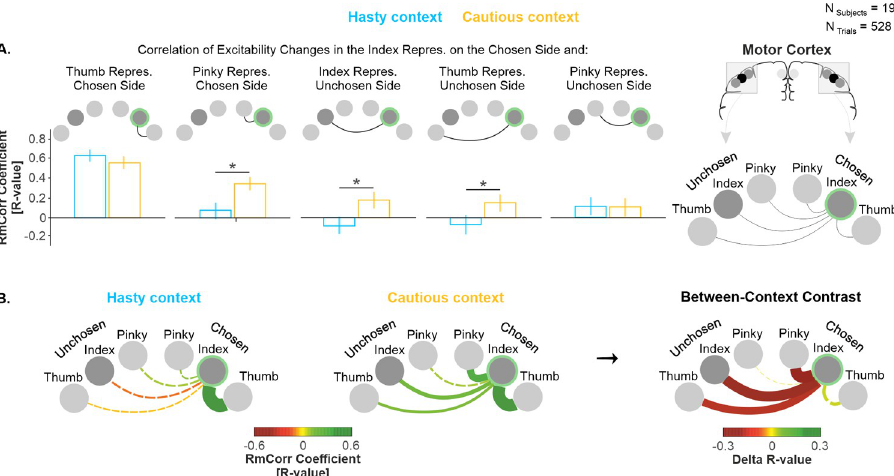
Error bars represent 95% CI. � indicates a significant difference between R-values at p < 0.01 (Bonferroni-corrected threshold), detected using Fisher Z test. (B) Network plots. The color and thickness of the lines in the left and middle panels represent the strength of the correlations, as indexed by RmCorr’s R-values. Solid and dashed lines represent significant and nonsignificant correlations, respectively. In the right panel, the color and thickness of the lines represent the difference in R-values between the cautious and the hasty context. Solid and dashed lines represent significant and nonsignificant different in correlation, respectively, as determined using Fisher Z test. All individual and group-averaged numerical data exploited for Fig 6 are freely available at this link: https://osf.io/tbw7h. CI, confidence interval; rmCorr, repeated measures